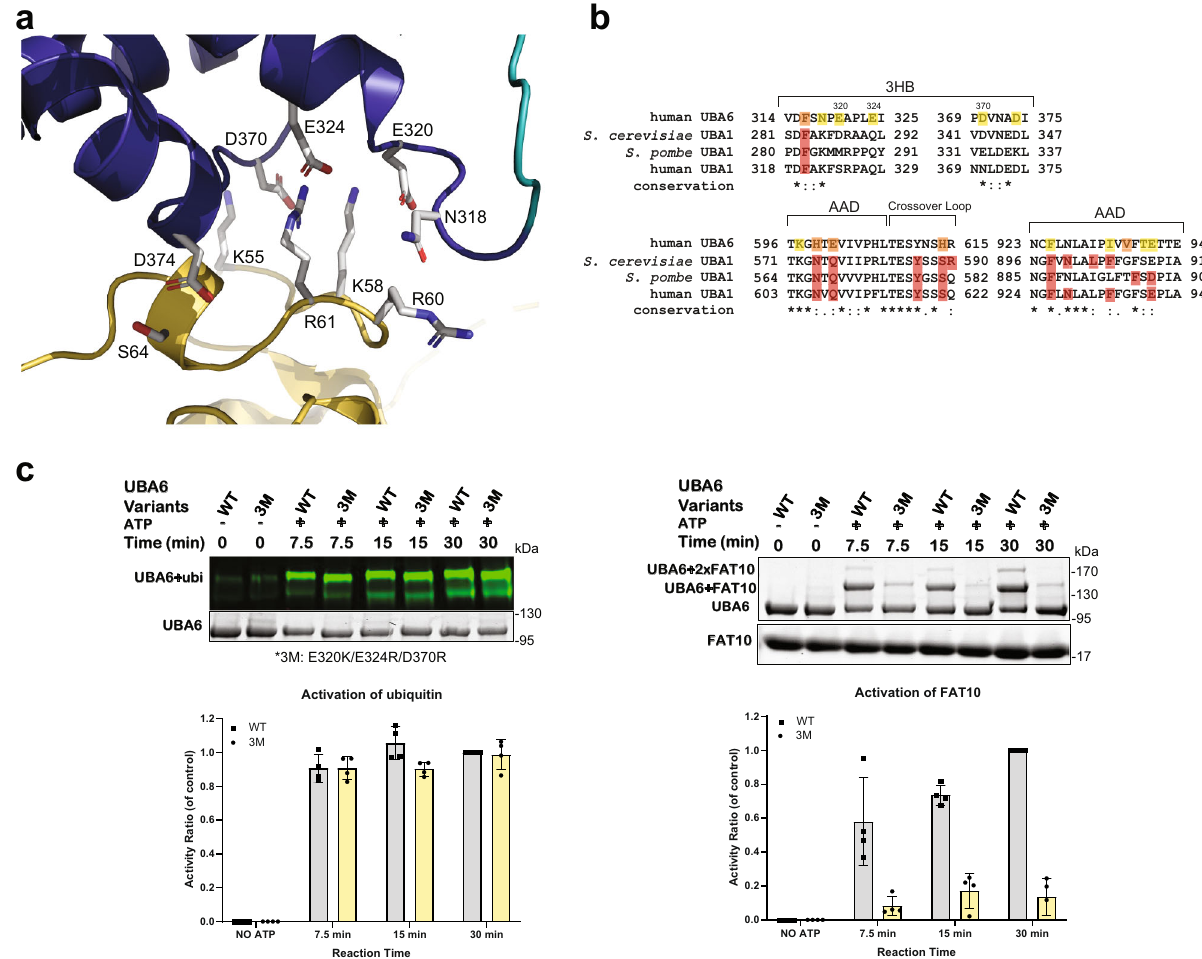
Fig. 5 | UBA6-FAT10(NTD) interface and selectiveelimination ofFAT10ylation. a Interactions between the FAT10 NTD (yellow) and the 3HB (dark blue) of UBA6. b Partial sequence alignment of UBA6 and UBA1 orthologs highlighting residues only interacting with either FAT10 (yellow) or with ubiquitin (red) and residues which interact with both FAT10 and ubiquitin (orange). c Ubiquitylation (left) and